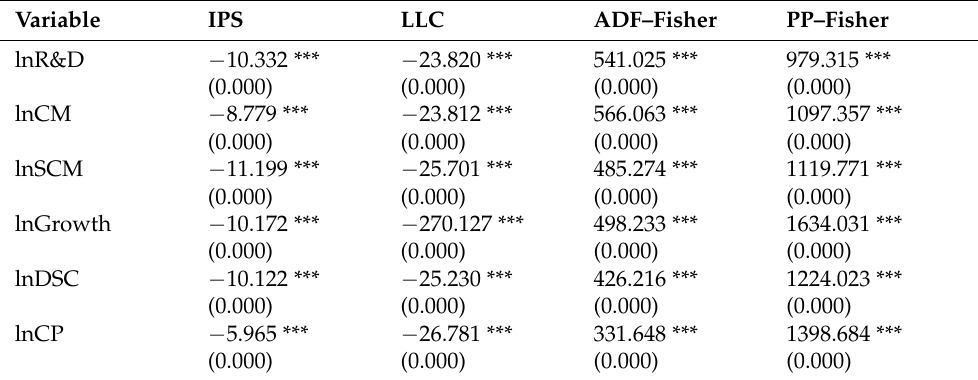
Table 3. Results of stationarity